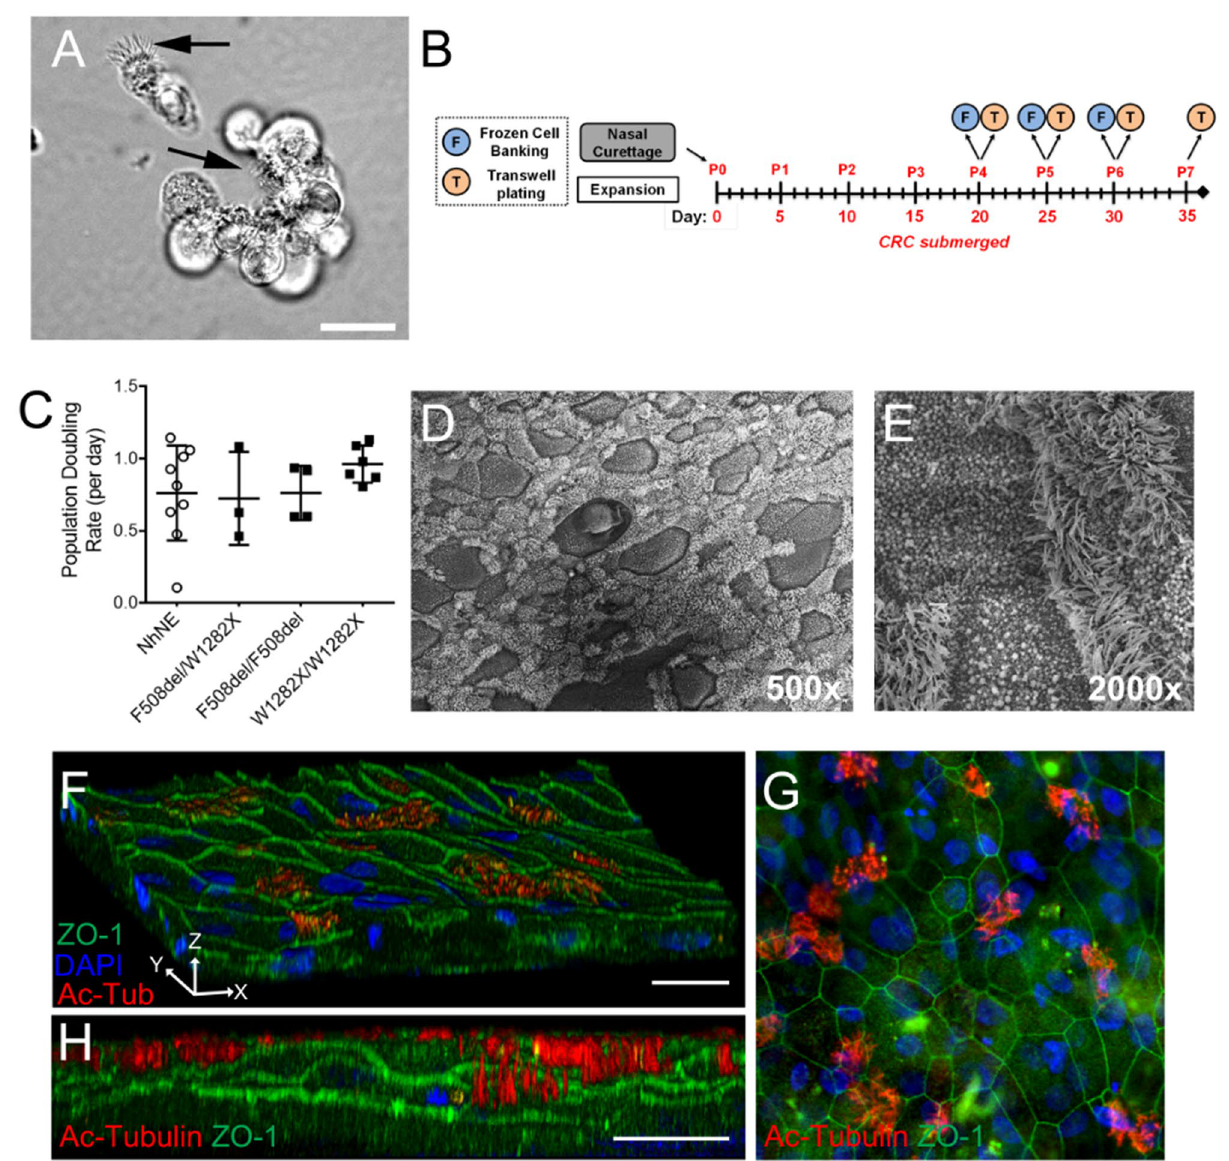
Figure 5. Expansion and differentiation of non-CF and CF nasal epithelial cells. ( A ) Ciliated cells (black arrows) are observed in freshly isolated CF nasal cultures by phase contrast microscopy. Bar, 20 μm. ( B ) Timeline for processing of nasal curettage samples showing frozen cell banking (F), plating for differentiation on Transwell permeable supports (T) or plating for expansion in FYRM submerged culture. Due to the small initial sample size, cells were not banked or plated for differentiation until P4. Cells beyond P7 are not typically used to generate differentiated cultures for experimental analysis. Detail related to culture on Transwells (T) is shown in Fig. 2. ( C ) Non-CF and CF nasal epithelial cells with 3 different genotypes had a comparable doubling time when cultured in CRC conditions. n = 3 – 6 wells for CF cells; doubling data for NhNE cells is from Fig. 2. ( D , E ) Cilia and mucus producing CF nasal epithelial cells as observed by scanning electron microscopy at 500x ( D ) and 2000x ( E ) magnification. ( F – H ) Immunofluorescence confocal microscopy of CF nasal airway cells showed tight junctions (green, ZO-1) and cilia (red, Ac-Tubulin). Nuclei were labeled with DAPI (blue). Bar, 20 μm ( F , H